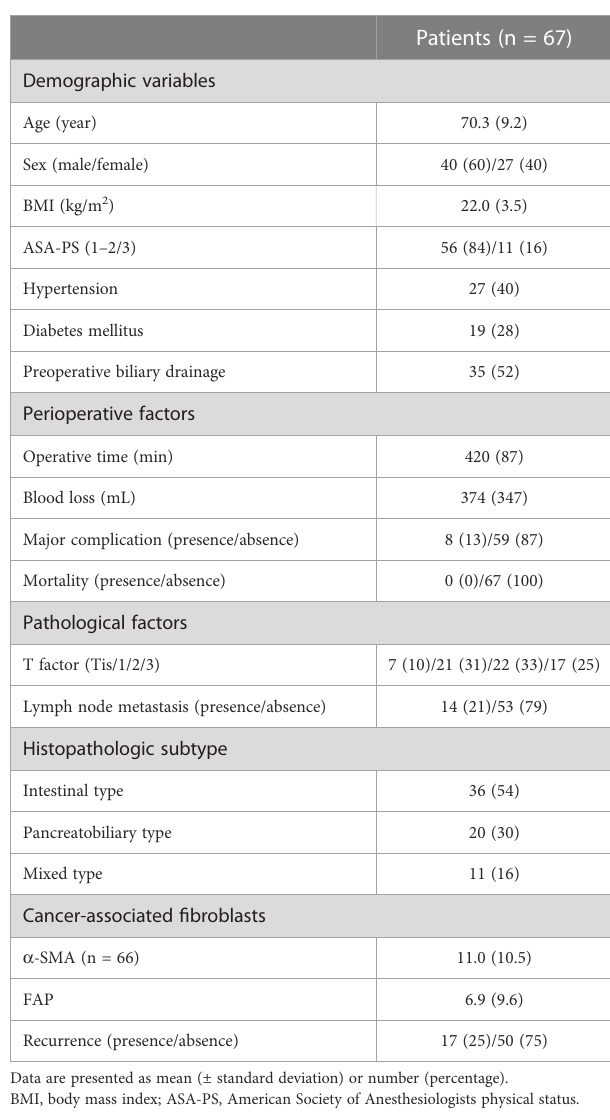
TABLE 1 Clinicopathological characteristics of patients with ampullary carcinoma.